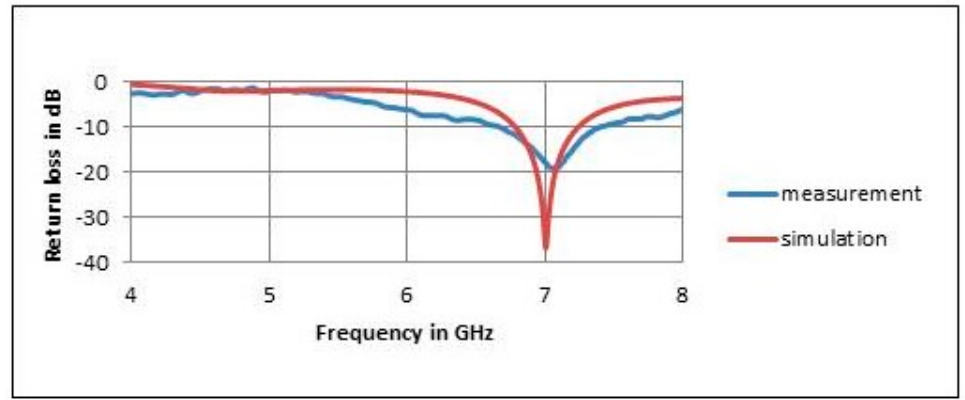
Figure 6. The comparison of simulated and measured return loss of antenna A.